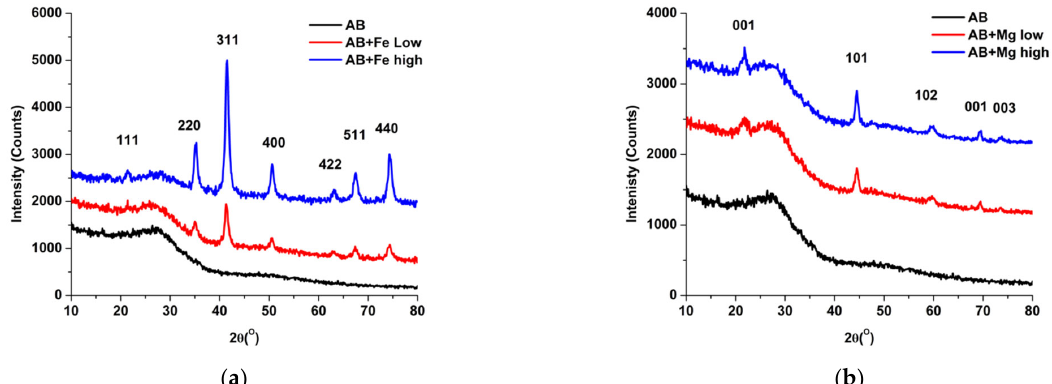
Figure 1. XRD pattern of avocado seed biochar (AB): ( a ) Fe ‐ loaded AB and ( b ) Mg ‐ loaded AB.